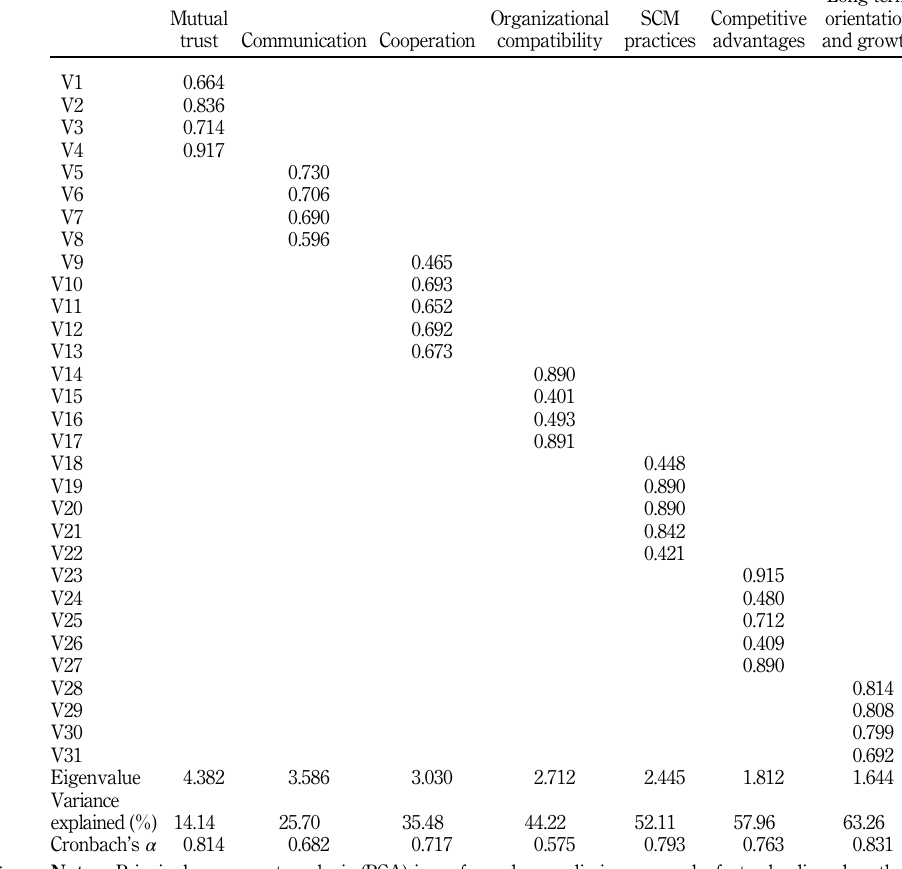
Table I. Result of principle component analysis (preliminary